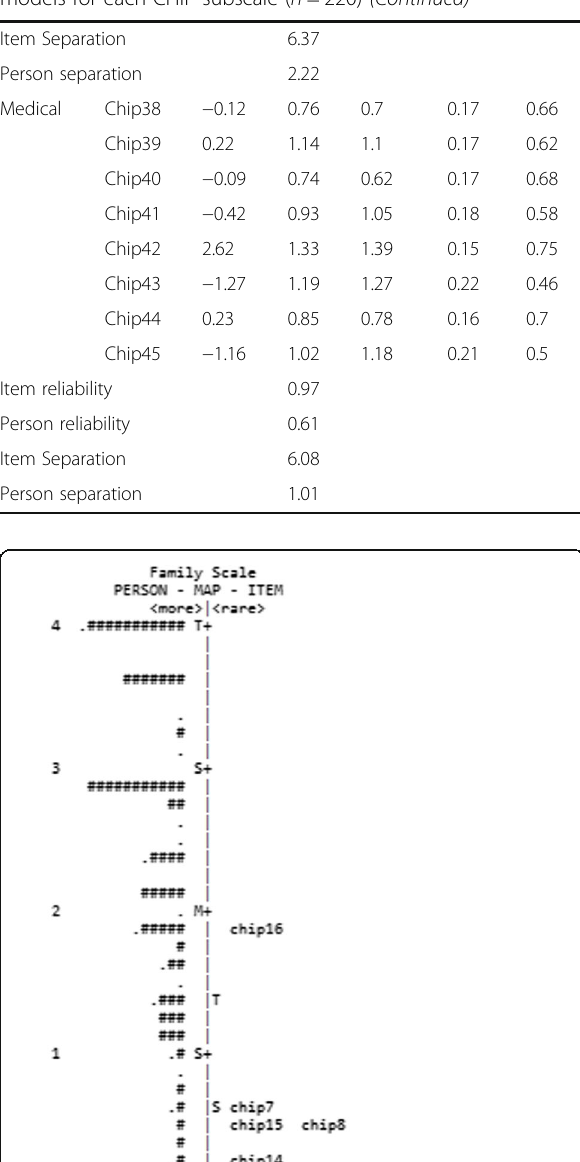
Table 3 Parameters and fit of items to the measurement models for each CHIP subscale ( n = 220) (Continued)